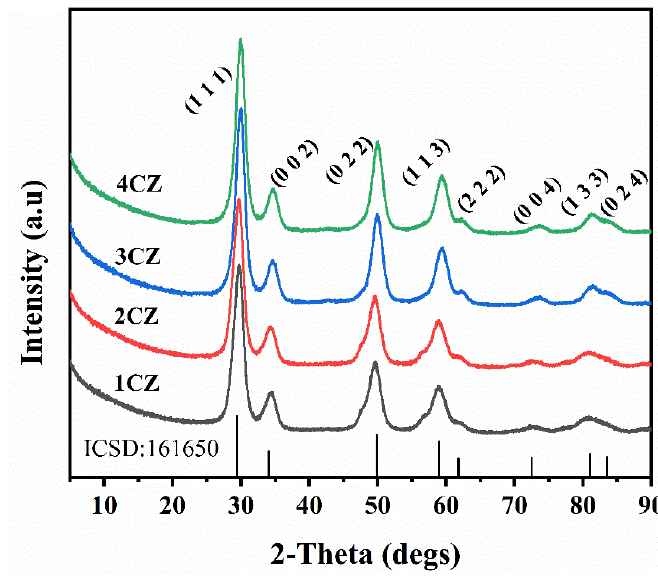
Figure 3. XRD analysis of the CZ nanoparticles.